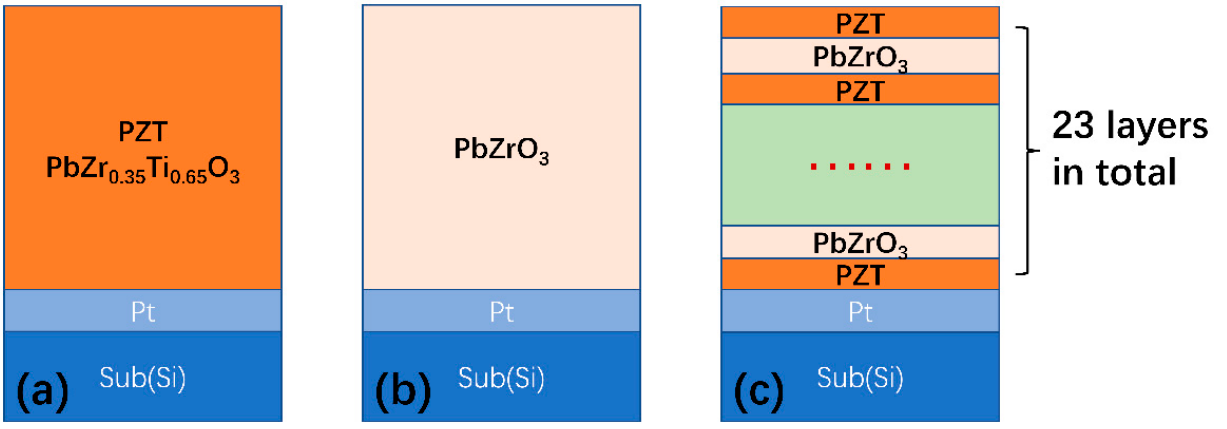
Figure 1. Schematic diagrams of the ( a ) PZT film, the ( b ) PZO film, and the ( c ) PZT/PZO multilayers, respectively.